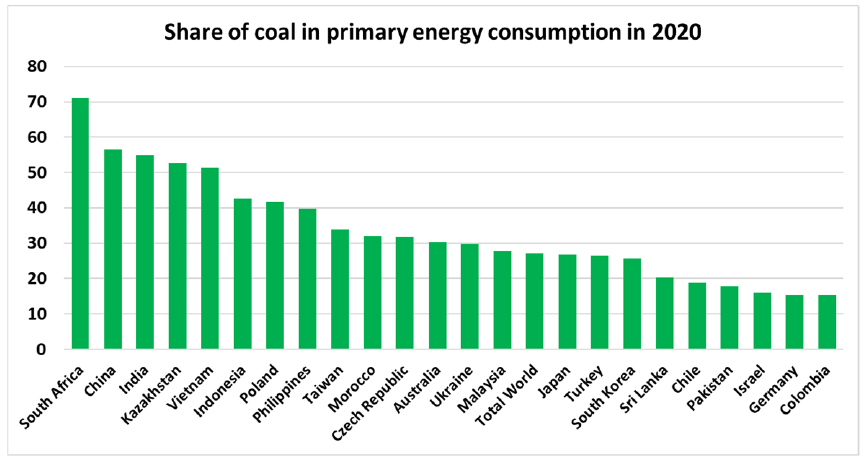
Figure 5. Countries in which the shares of coal in primary energy consumption are the largest in 2020, % [5].